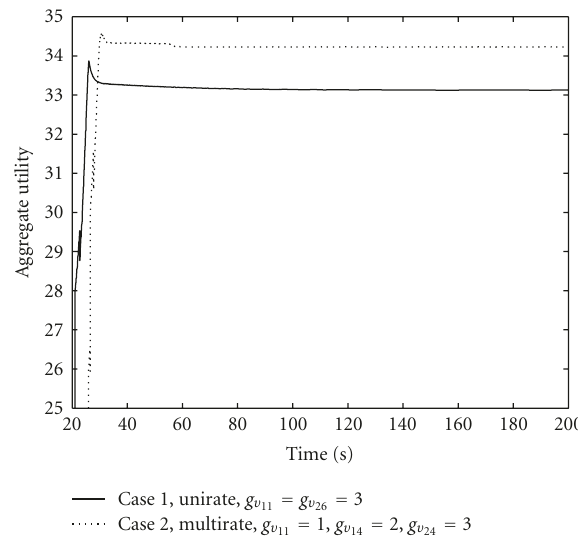
Figure 15: Aggregate utilities for cases 1 (unirate) and 2 (multirate).